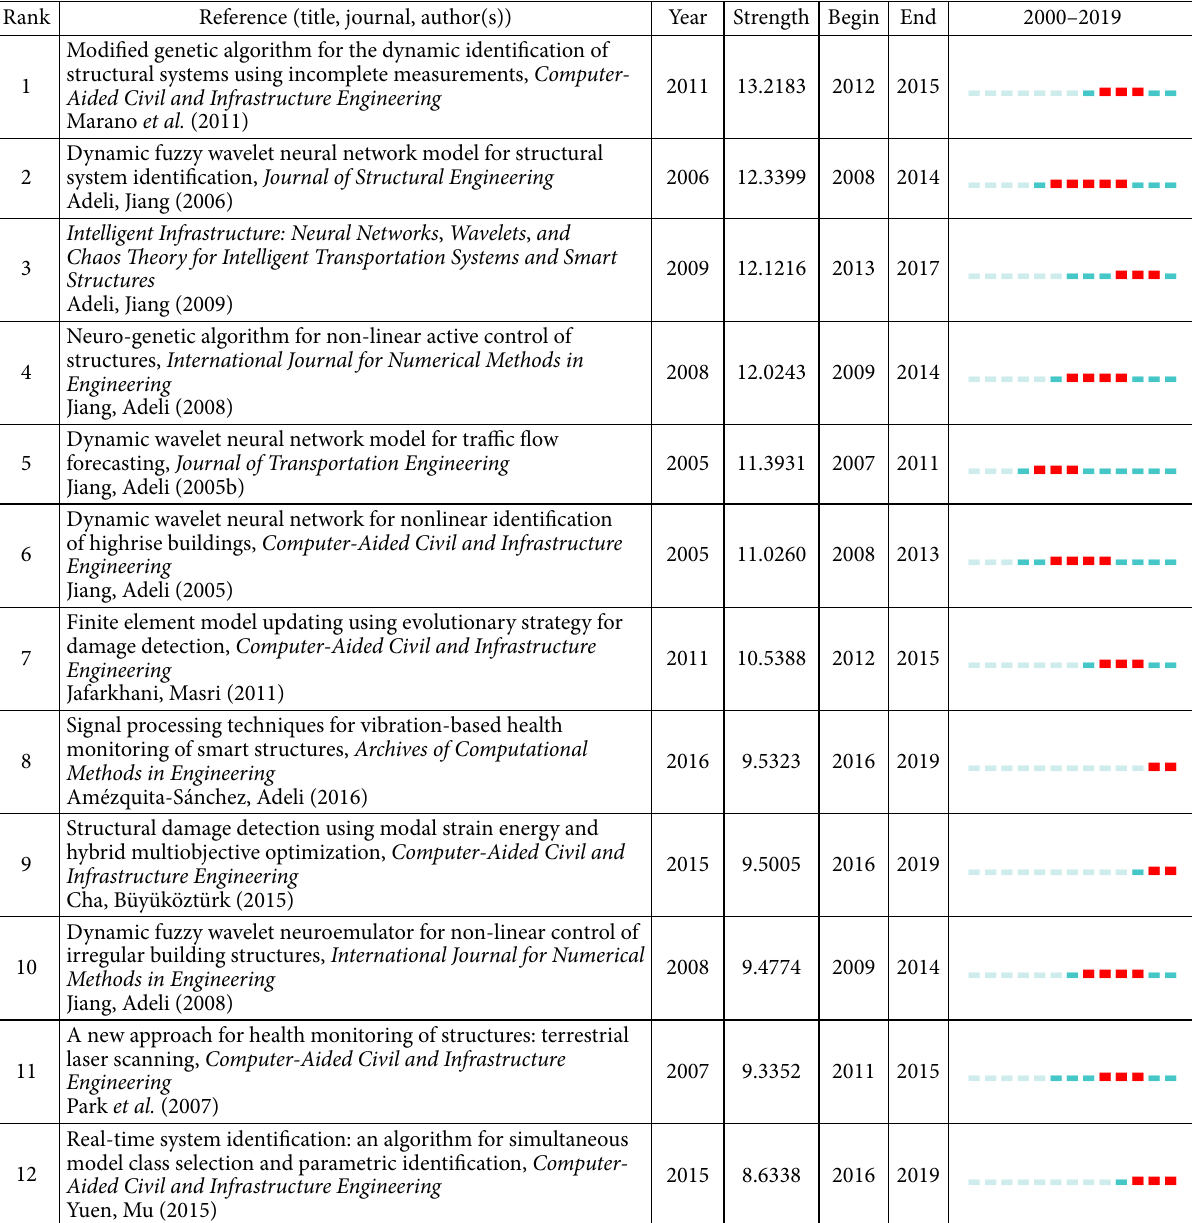
Table 3. The top 12 strongest cited references in the CACAIE from 2000 to 2019